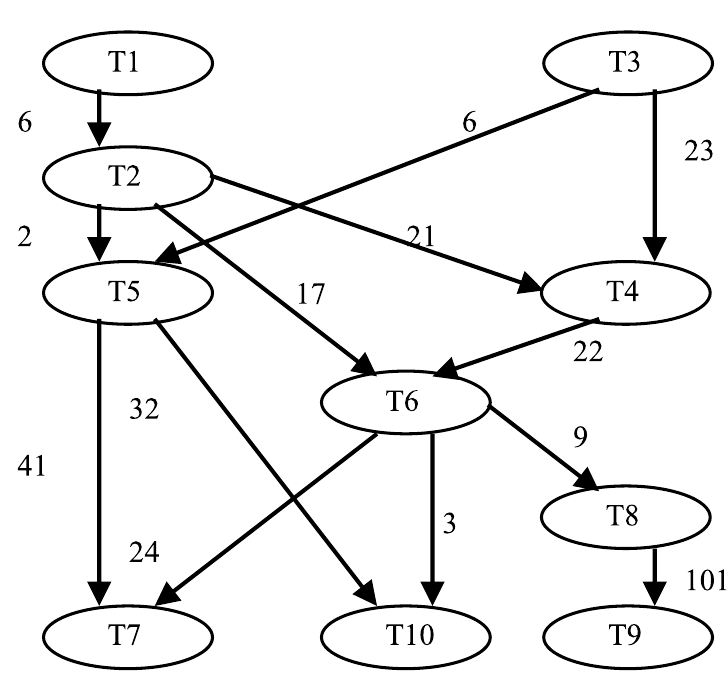
Fig. 3 Model task graph (using 10 tasks)